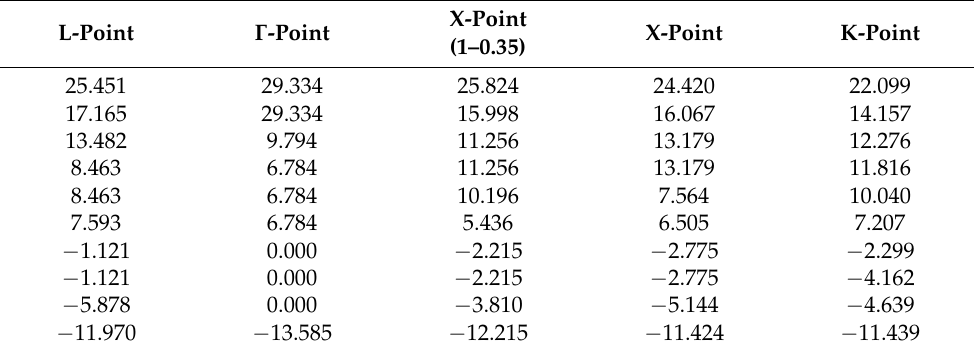
Table 3. Calculated, electronic energies (in eV) of zb-BeS, at high symmetry points in the Bril- louin zone, obtained from calculation III, using the BZW-EF method, with an experimental room temperature lattice constant of 4.863 Å. The indirect band gap from Γ to X to 5.436 eV. Γ -Point